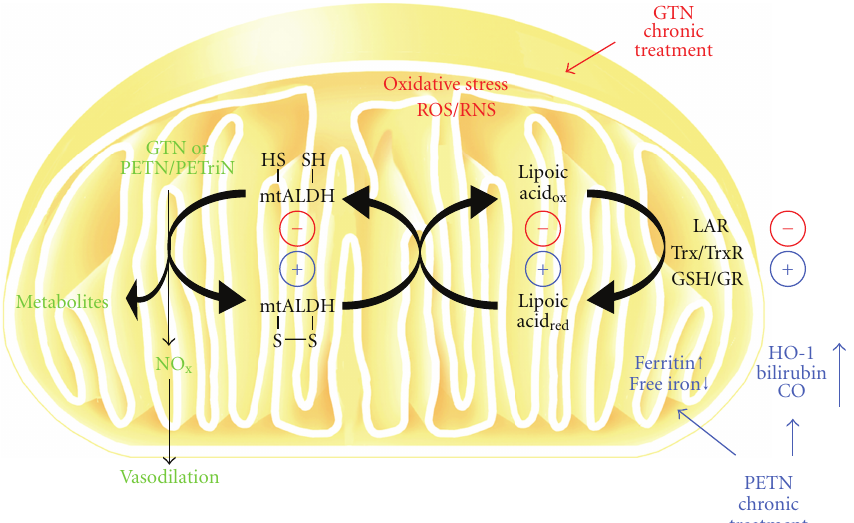
Figure 3: Scheme illustrating the mechanisms underlying the oxidative stress concept of nitrate tolerance in response to GTN treatment and the mechanisms underlying the beneficial vascular e ff ects in response to PETN. PETN and GTN are bioactivated by mitochondrial ALDH (ALDH-2) yielding 1,2-glyceryl dinitrate and PETriN, respectively, as well as a yet undefined nitrogen species (NO x , probably nitrite) that undergoes further reduction by the mitochondrial respiratory chain or acidic disproportionation to form an activator of sGC (probably nitrico xide). GTN treatment induces mitochondrial reactive oxygen and nitrogen species formation (ROS/RNS). These ROS/RNS in turn inhibit the GTN bioactivation process by inactivation of ALDH-2 or by inhibiting the repair system of the ALDH-2, which includes lipoic acid, as well as a reductase system depending on the NADH or NADPH (lipoicacid reductase (LAR), thioredoxin/thioredoxin reductase (Trx/TrxR) or glutathione/glutathione reductase (GSH/GR). In contrast to GTN, PETN provides potent antioxidative e ff ects by inducing HO-1 and ferritin, which in turn decrease ROS levels and therefore protect the ALDH-2 from ROS mediated inactivation. Adapted from